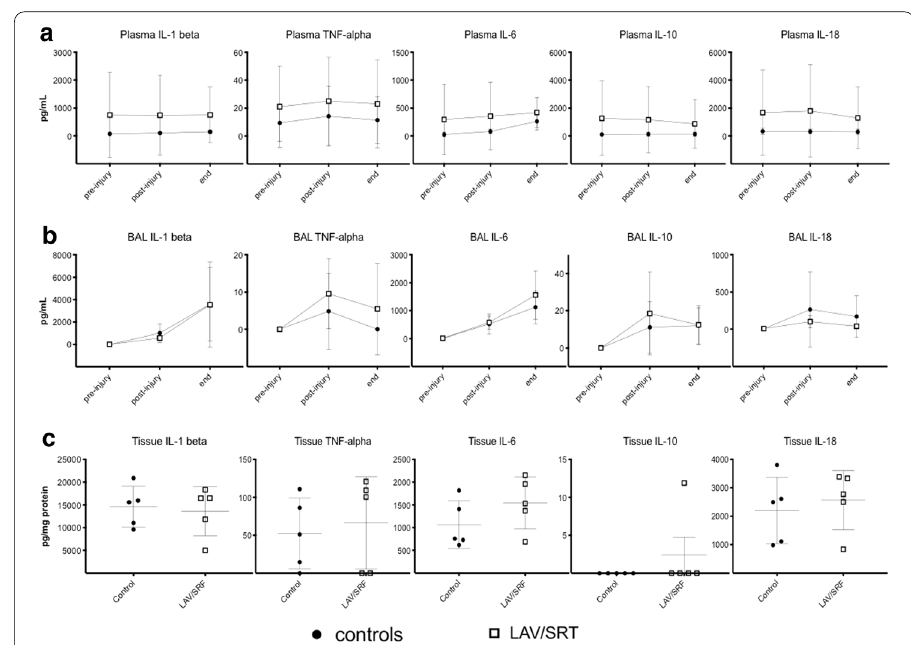
Fig. 6 a Plasma and b bronchoalveolar lavage (BAL) cytokines profile over time (pre-injury, post-injury and end), and c cytokines from lung tissue biopsy taken at the end of the experiment. Data are presented as mean SD. Two-way ANOVA for repeated measures analysis in a , b : p > 0.05 controls vs LAV/SRT. Mann– ± Whitney test analysis in c , p > 0.05 controls vs